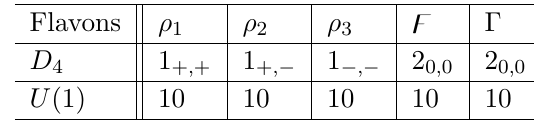
Table 3 . The D 4 × U(1) quantum numbers of the flavons used in the neutrino